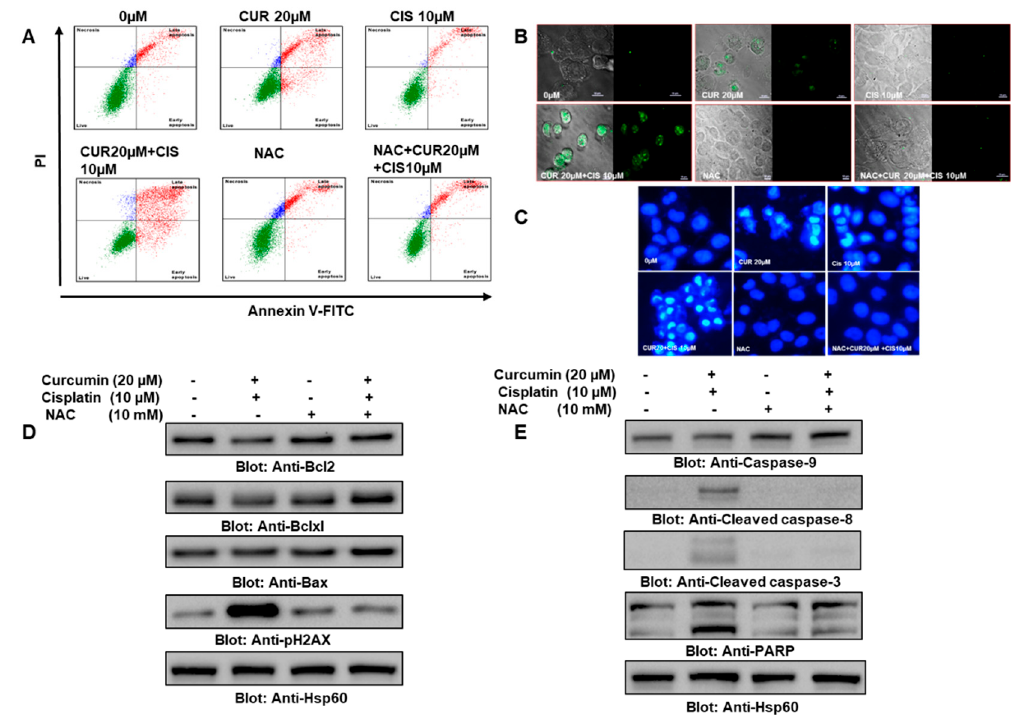
Figure 7. Curcumin potentiated the cisplatin-mediated apoptosis of PTC cells via enhanced oxidative stress. ( A ) NAC pretreatment prevented the curcumin- and cisplatin-mediated apoptosis of PTC cells. BCPAP cells were treated with 0 µ M and 20 µ M of curcumin and 10 µ M cisplatin, 20 µ M curcumin plus 10 µ M cisplatin, NAC (10 mM) and NAC plus 20 µ M curcumin and 10 µ M cisplatin for 24 h; cells were subsequently stained with fluorescein-conjugated Annexin-V and propidium iodide (PI) and analyzed by flow cytometry; apoptosis was measured; and the percentage of apoptosis relative to untreated cells was calculated. ( B ) NAC pretreatment prevented curcumin- and cisplatin-induced increased ROS generation in PTC cells. BCPAP cells were treated with 0 µ M or 20 µ M of curcumin and 10 µ M of cisplatin alone and in combination or were treated with NAC (10 mM) and NAC + curcumin and cisplatin for 24 h; cells were fixed and subsequently stained with 2 (cid:48) ,7 (cid:48) –dichlorofluorescin diacetate (DCFDA); and images were taken through confocal microscopy at 60X magnification (scale bar: 25 µ m). DCFDA is well known for measuring the various ROS species: once it di ff uses inside the cells, it gets deacetylated by cellular esterases, leading to the formation of a non-fluorescent compound. Next, cellular ROS oxidized DCFDA into a highly fluorescent compound known as dichlorofluorescein (DCF), which can be detected by fluorescence spectroscopy. ( C ) NAC pretreatment attenuated curcumin- and cisplatin-induced damage in PTC cells. We observed increased nuclear condensation, distorted membrane integrity, moderate chromatin condensation, and nuclear fragmentation in the cells challenged with both cisplatin and curcumin, while the control and NAC-treated cells depicted di ff use nuclear staining with intact membrane integrity. BCPAP cells were treated with 0 µ M or 20 µ M of curcumin and 10 µ M of cisplatin alone and in combination or NAC (10 mM) and NAC + curcumin and cisplatin for 24 h, and cells were fixed and subsequently stained with 4 (cid:48) ,6-diamidino-2-phenylindole (DAPI). Images were taken through an EVOS FLc Cell Imaging System from Invitrogen (Thermo Fisher Scientific) at 40 × magnification (scale bar: 100 µ m). ( D ) NAC prevented curcumin- and cisplatin-induced modulation in the expression of antiapoptotic and proapoptotic proteins in PTC cells. BCPAP cells were pretreated with NAC (10 mM), followed by a combination treatment of 20 µ M curcumin and 10 µ M cisplatin, and after cell lysis, equal amounts of proteins were separated by SDS-PAGE, transferred to a PVDF membrane, and immunoblotted with antibodies of Bcl2, Bcl-xL, Bax, and Hsp60. ( E ) NAC prevented curcumin- and cisplatin-induced activation of caspase-mediated apoptosis in PTC cells. BCPAP cells were pretreated with NAC (10 mM), followed by a combination treatment of 20 µ M curcumin and 10 µ M cisplatin, and after cell lysis, equal amounts of proteins were separated by SDS-PAGE, transferred to a PVDF membrane, and immunoblotted with antibodies of caspase-9, cleaved caspase-8, cleaved caspase-3, PARP, and Hsp60. CUR: curcumin; CIS: